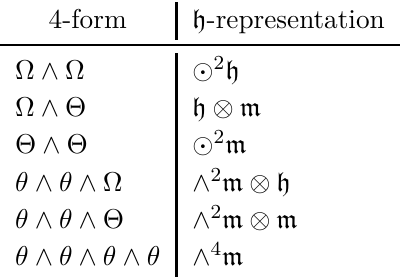
Table 5 . Four-forms (schematically) and their representations